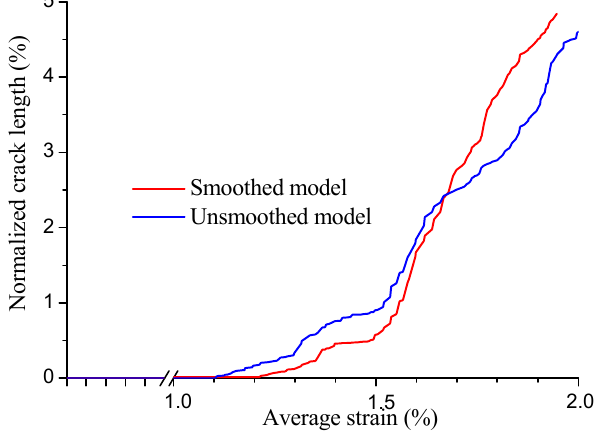
Figure 13. Normalized lengths of cracks in smoothed and unsmoothed model.